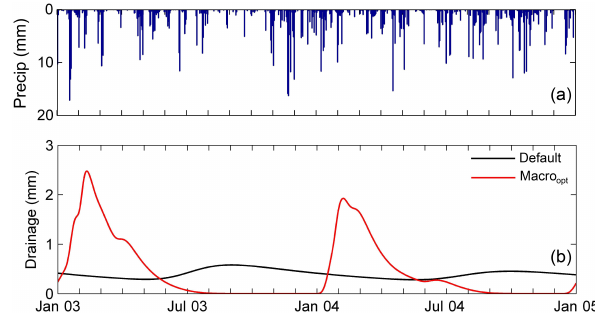
Figure 6. (a) Daily precipitation and (b) daily drainage through the bottom of the soil column at Warren Farm over the 2 simulated years (2003–2005).